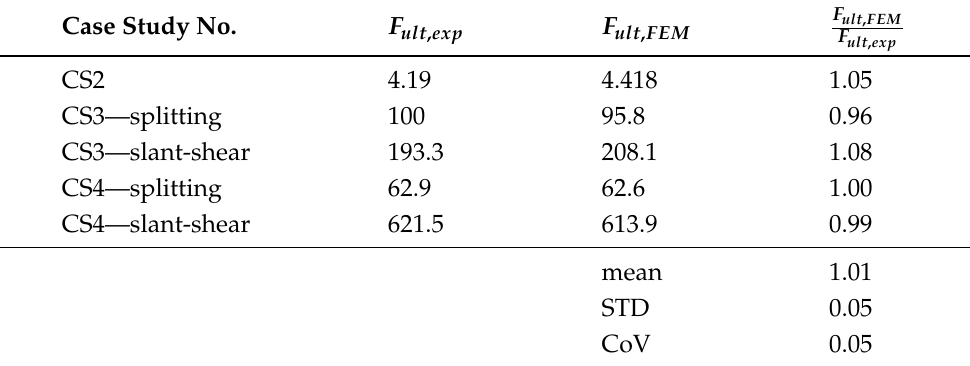
Table 10. Summary of the performed validation tests. Case Study